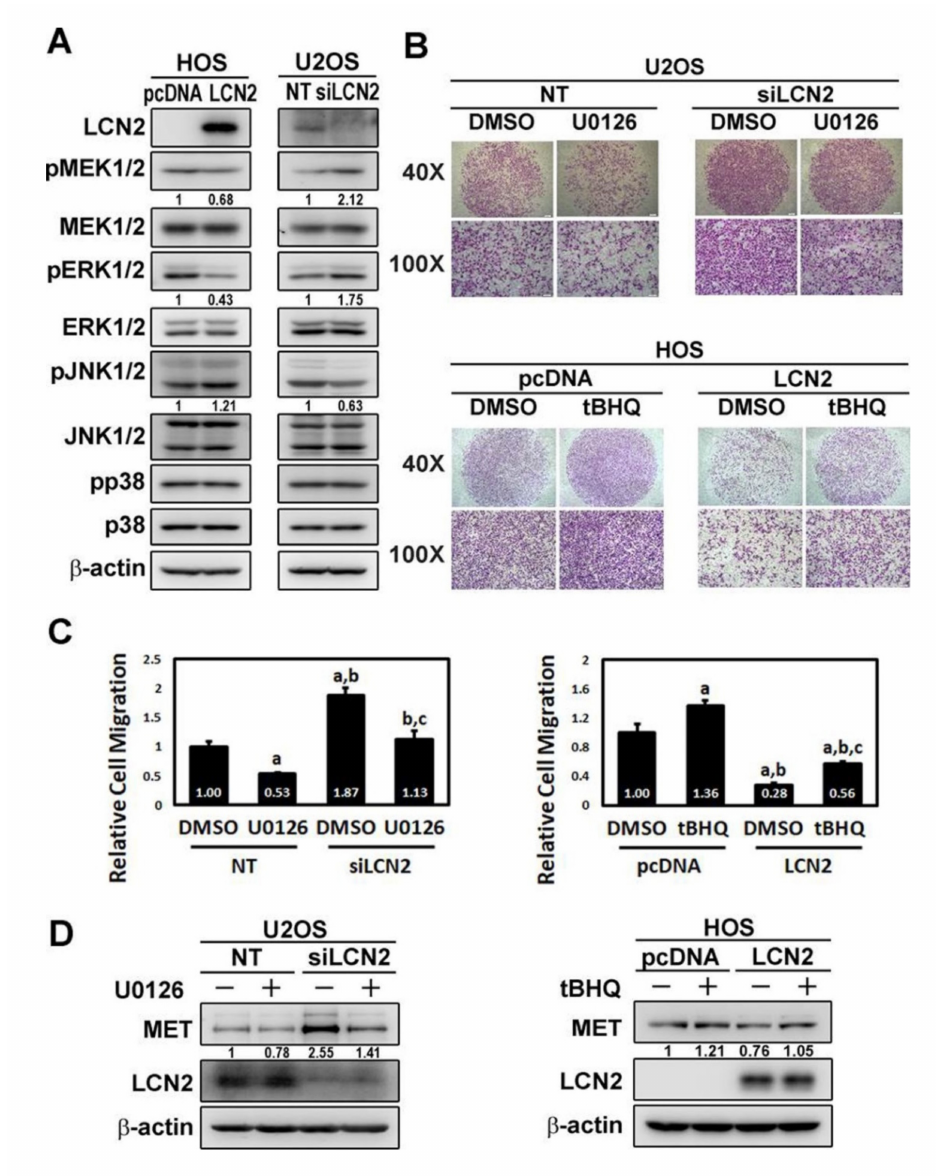
Figure 5. Effects of LCN2 on MEK and MAPKs to modulate MET and migration in U2OS and HOS cells. ( A ) Western blot analyses for HOS cells with or without overexpression of LCN2 and U2OS cells with or without knockdown of LCN2 to determine MEK and MAPKs, including their phosphorylation, were conducted, respectively. ( B , C ) Cell migration assays for effects of the inhibitor of ERK (U0126) on U2OS cells with or without silencing of LCN2 and the activator of ERK (tBHQ) on HOS cells with or without overexpression of LCN2 were measured and subsequently subjected to quantitative analysis. U2OS: F: 110,894, p < 0.001; HOS: F: 168,737, p < 0.001. a Significantly different, p < 0.05, when compared with U2OS cells without silencing of LCN2 and without U0126, or HOS cells without overexpression of LCN2 and without tBHQ. b Significantly different, p < 0.05, when compared with U2OS cells without silencing of LCN2 but with U0126, or HOS cells without overexpression of LCN2 but with tBHQ. c Significantly different, p < 0.05, when compared with U2OS cells with silencing of LCN2 but without U0126, or HOS cells with overexpression of LCN2 but without tBHQ. ( D ) Western blot analysis for U2OS cells with or without silencing of LCN2 and HOS cells with or without overexpression of LCN2 to determine effects of U0126 and tBHQ on MET and LCN2 expressions were